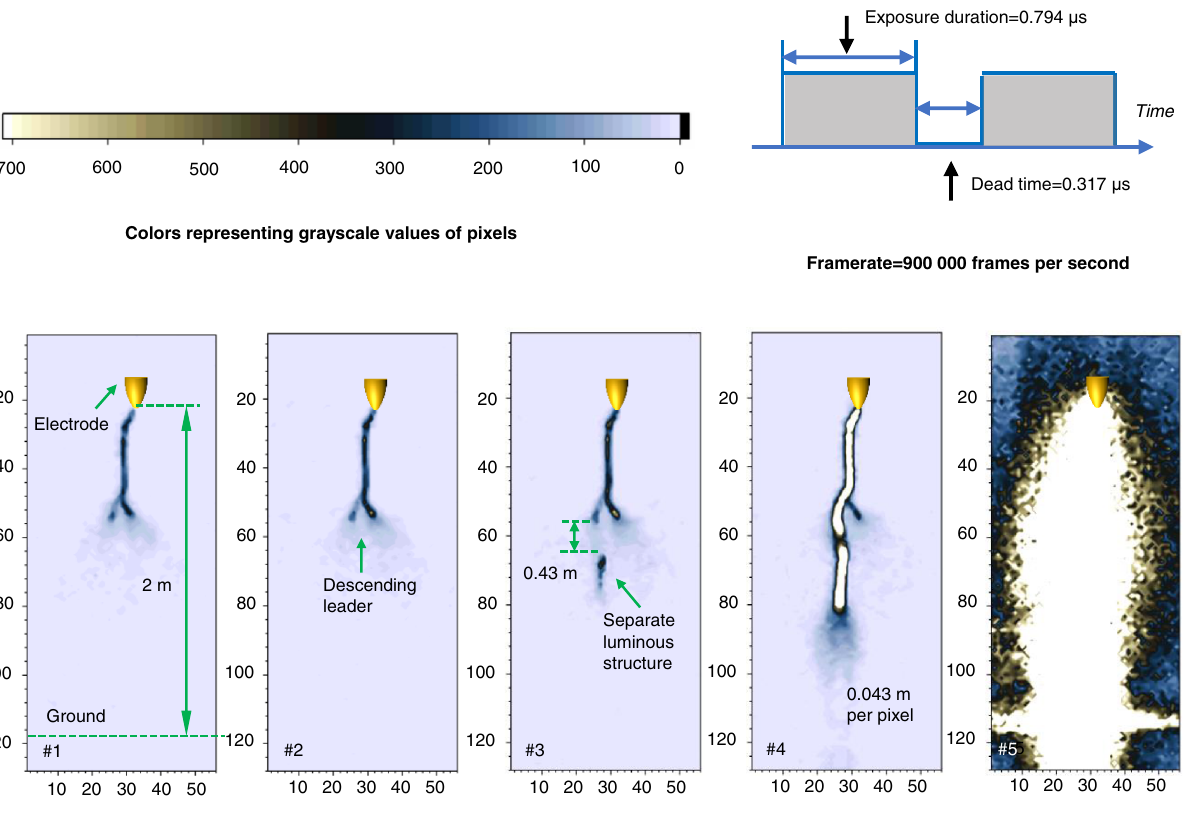
Fig. 4 Bi-directional development of the separate luminous structure. The original high-speed video frames recording the positive leader step are grayscale images with 12-bit pixel depth, photography by a Photron FASTCAM SA-Z high-speed camera. A Canon TV-16 lens (25 mm 1:0.78) was used. The framerate was set as 900,000 frames per second. The exposure duration of each frame is 0.794 μ s, and the interval between two adjacent frames (dead time) is 0.317 μ s. The resolution of these frames is 56 (in width) × 128 pixels (in height). The fi eld of view covered the whole air gap (larger than 4 m). To enhance visibility, these frames were pseudo-colored and shown in the fi gure. The color of pixels in these frames represents the value in the grayscale matrix extracted from the original frames. Pixels with grayscale exceeding 700 are displayed in white. The coordinate marked in these frames represents the row and column numbers of the grayscale matrix. The 4-m long gap occupies 92 rows in the grayscale rows, indicating the spatial resolution of these frames is about 0.043 m per pixel. During the experiment, the relative humidity is 74 ± 2%, the temperature is 301 ± 0.21 K, the air pressure is 1 atm, and the calculated absolute humidity is 20.11 ± 0.77 g/m 3